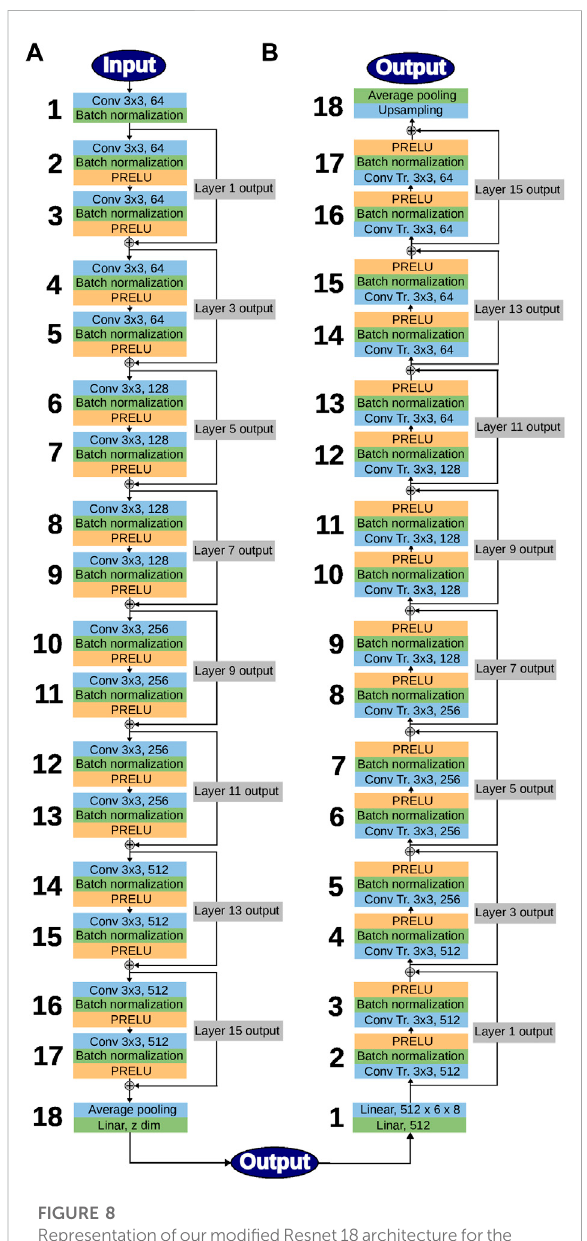
FIGURE 8 Representationofourmodi fi edResnet18architectureforthe encoder (A) andthedecoder (B) .Largenumbersontheleftofeach side label the different layers. Numbers such as 64, 128, etc. refer to the size of the fi ler; see text for a discussion of some of the main